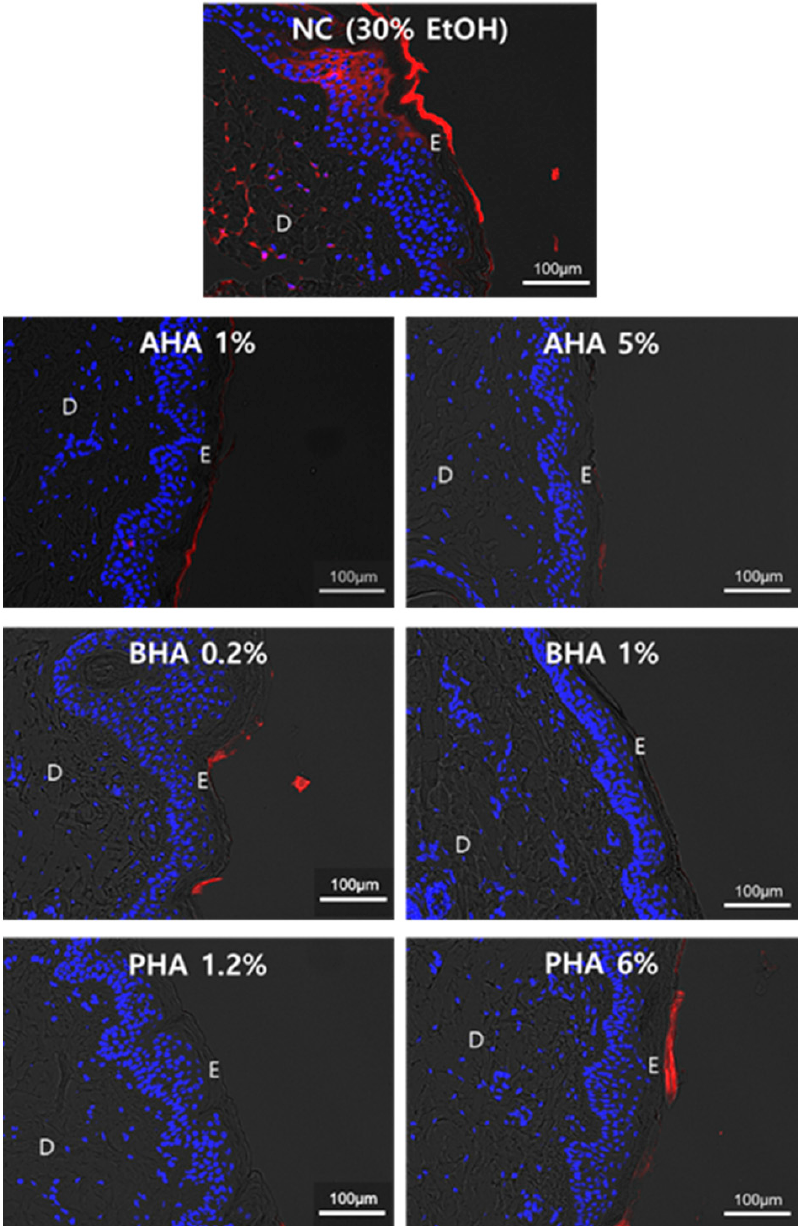
Figure 4. Effect of hydroxyacids on the skin penetration of rhodamine B Permeability of rhodamine B was evaluated after 24-h incubation of treated tissue. The fluorescent images represent rhodamine B (red) and DAPI (blue) staining. D: Dermis, E: Epidermis.